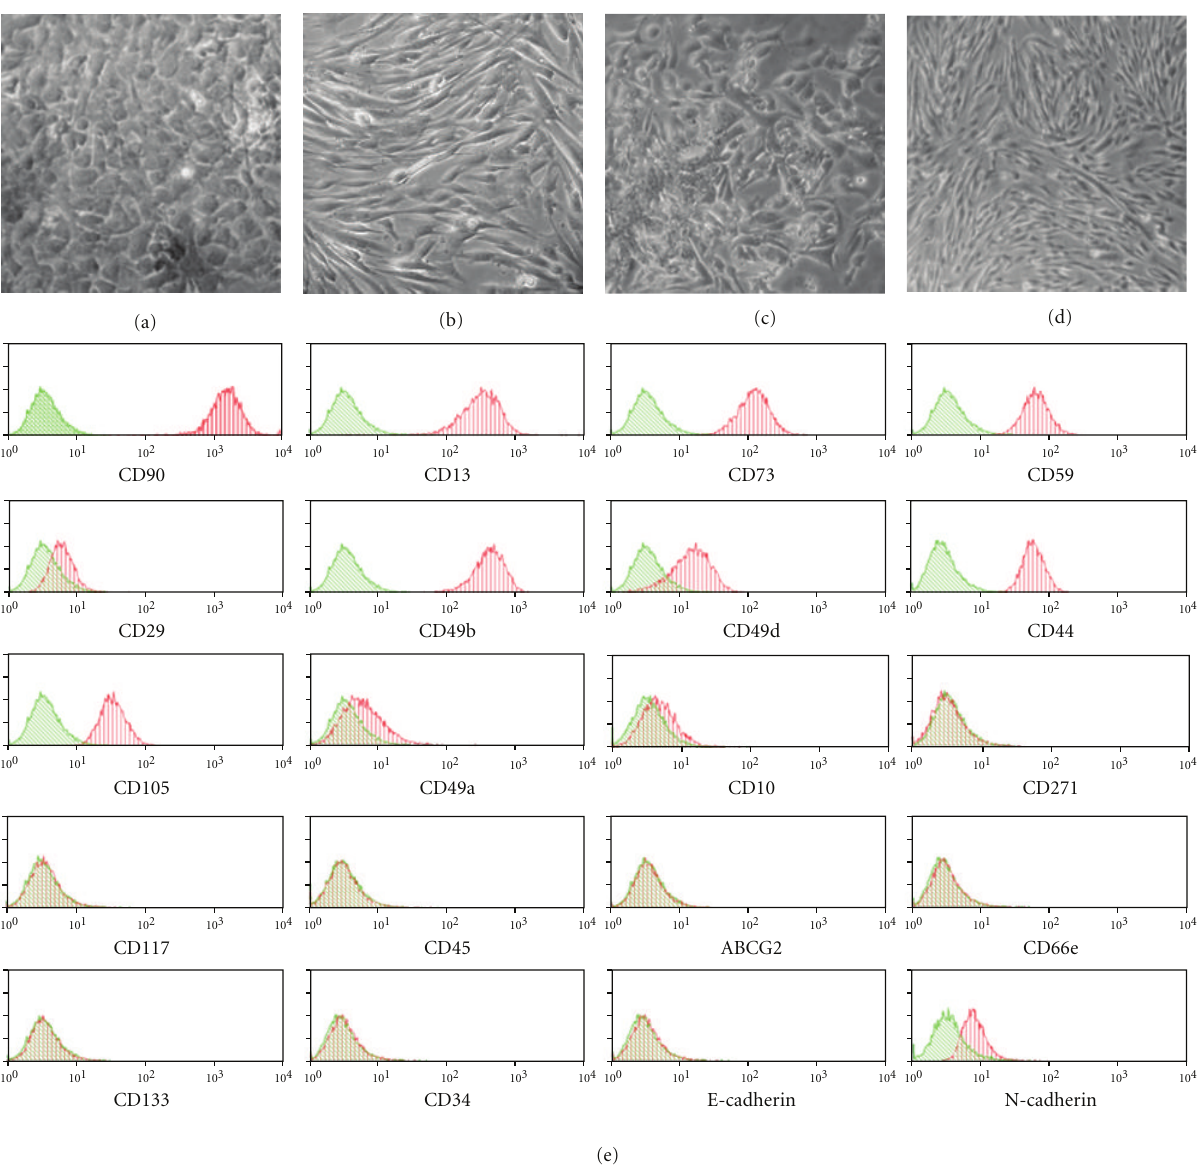
Figure 1: (a–d) Phase contrast images of C-MASCs (a, b) and N-MASCs (c, d) in primary culture (a–c) and at the third passage in culture (b, d). (e) FACS analysis of N-MASCs. Representative flow cytometry histograms of multipotent cell populations. Plots show isotype control IgG-staining profile (green histogram) versus specific antibody staining (red